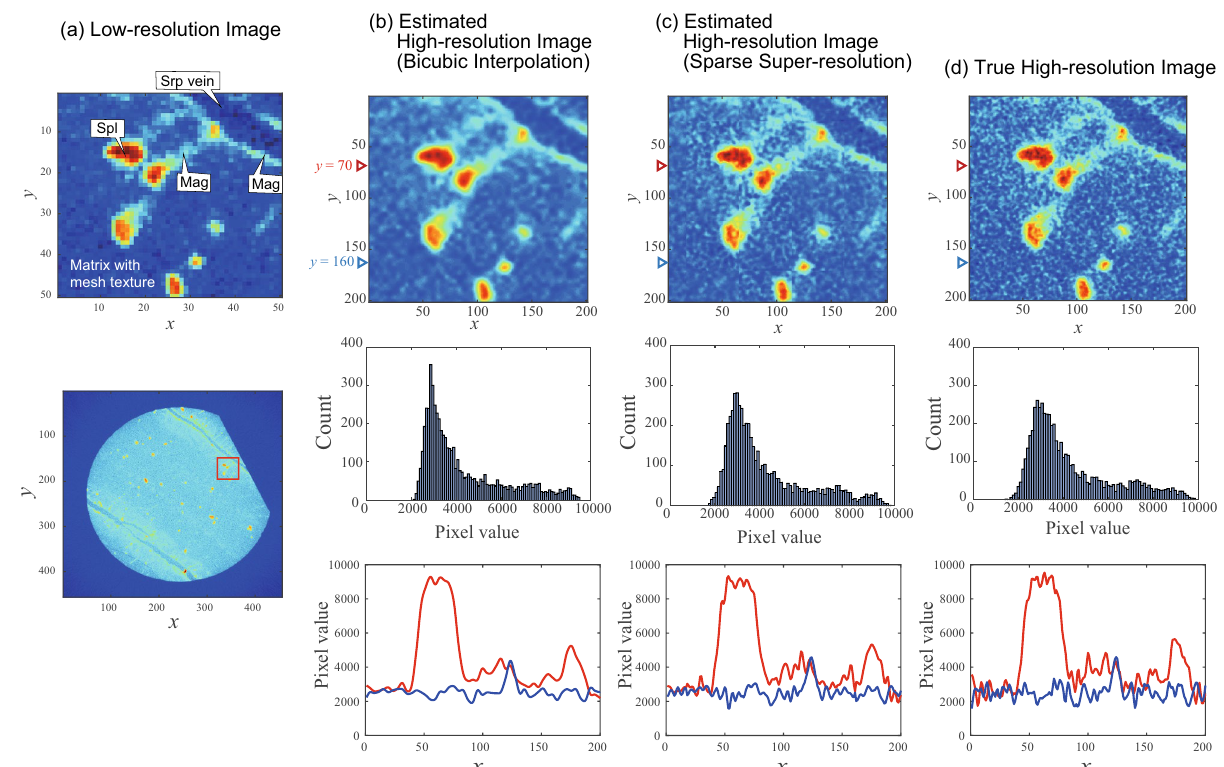
Figure 3. ( a ) Artificially created low-resolution X-ray image (top: enlarged image, bottom: entire image). Srp serpentine, Spl spinel, Mag magnetite. ( b ) Estimated high-resolution image by bicubic interpolation. ( c ) Estimated high-resolution image by sparse super-resolution. ( d ) True high-resolution image. For ( b – d ), top panel shows the high-resolution image, the middle panel shows a histogram of the pixel values in the two dimensional area of image), and the bottom panel shows the pixel values in the high-resolution image as a function of position x for a fixed value of y [ y = 70 (red line), and y = 160 (blue line)]. Voxel size of the high- resolution image was 10 µ m